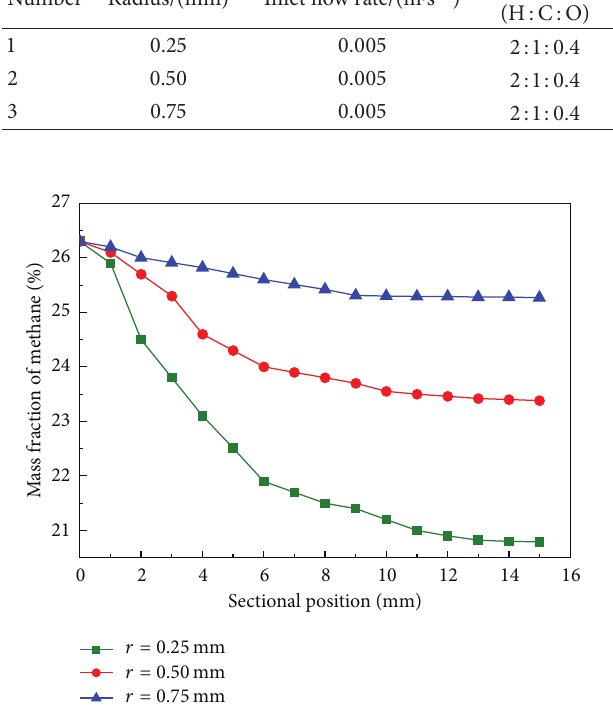
Figure 4: Methane conversion with cylinder radius of 0.25 mm ( ◼ ), 0.50 mm ( e ), and 0.75 mm ( 󳵳 ) for different reaction